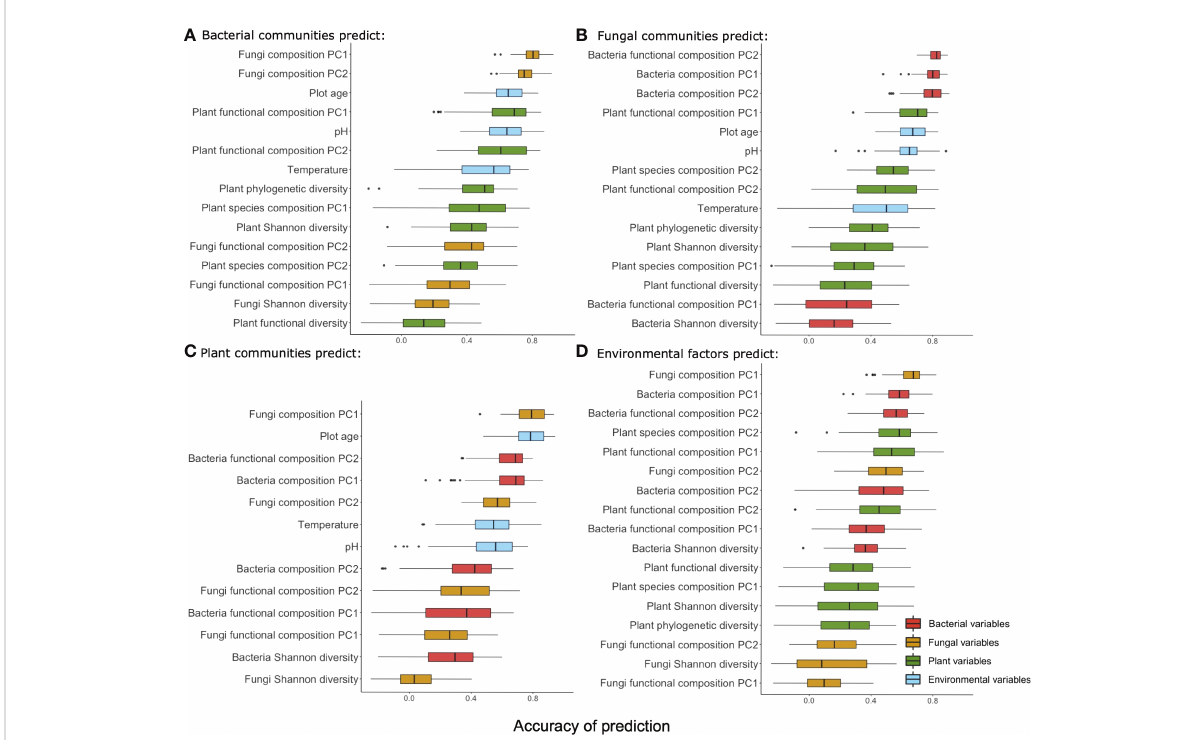
FIGURE 4 Summary of the accuracy of prediction using taxonomic groups (bacteria (A) , fungi (B) , plant (C) ) and environmental factors (D) to predict variables from the other three groups along the successional gradient. Variables from each group are color-coded (red: bacteria, orange: fungi, green: plant, blue: environment) and ranked by the mean accuracy of